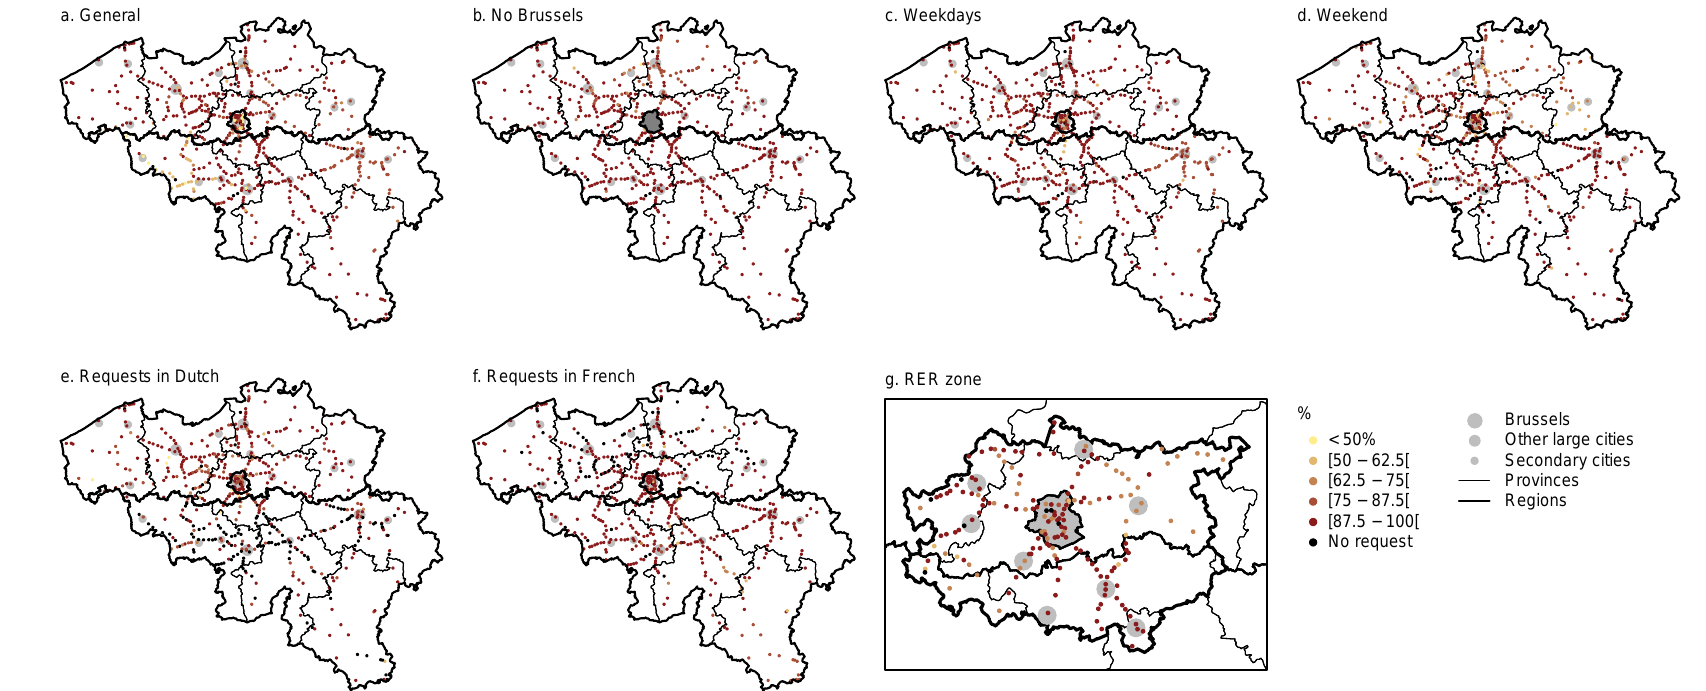
Figure A1. Stability of the communities by subset of the iRail dataset (number of times, over the 1000 iterations that a node is affected by its final community, in %). ( a ) General; ( b ) No Brussels; ( c ) Weekdays; ( d ) Weekend; ( e ) Requests in Dutch; ( f ) Requests in French; ( g ) RER